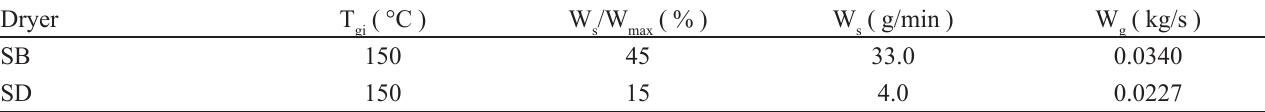
TABLE I - Spouted bed and spray drying parameters used in manufacture of the dried extract